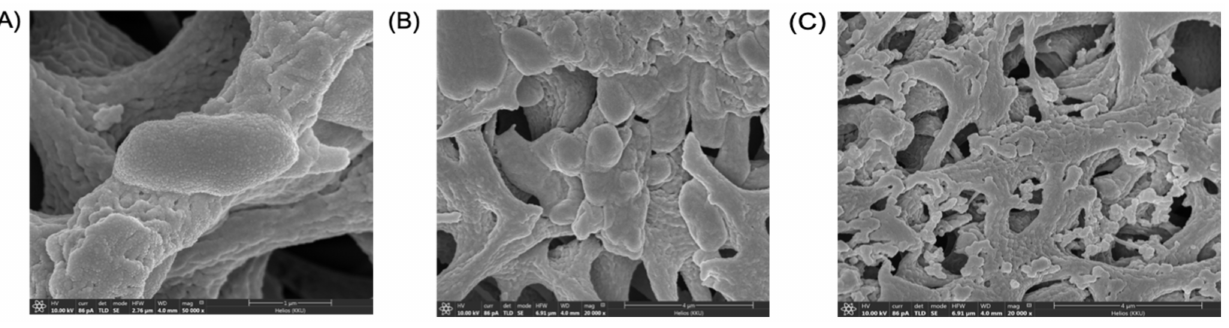
Figure 6. Scanning electron micrographs of E. coli treated with peptides: ( A ) control bacteria after treatment with 0.01% acetic acid for 1 h; ( B , C ) bacteria after treatment with MpVT at 2 × MIC for 1